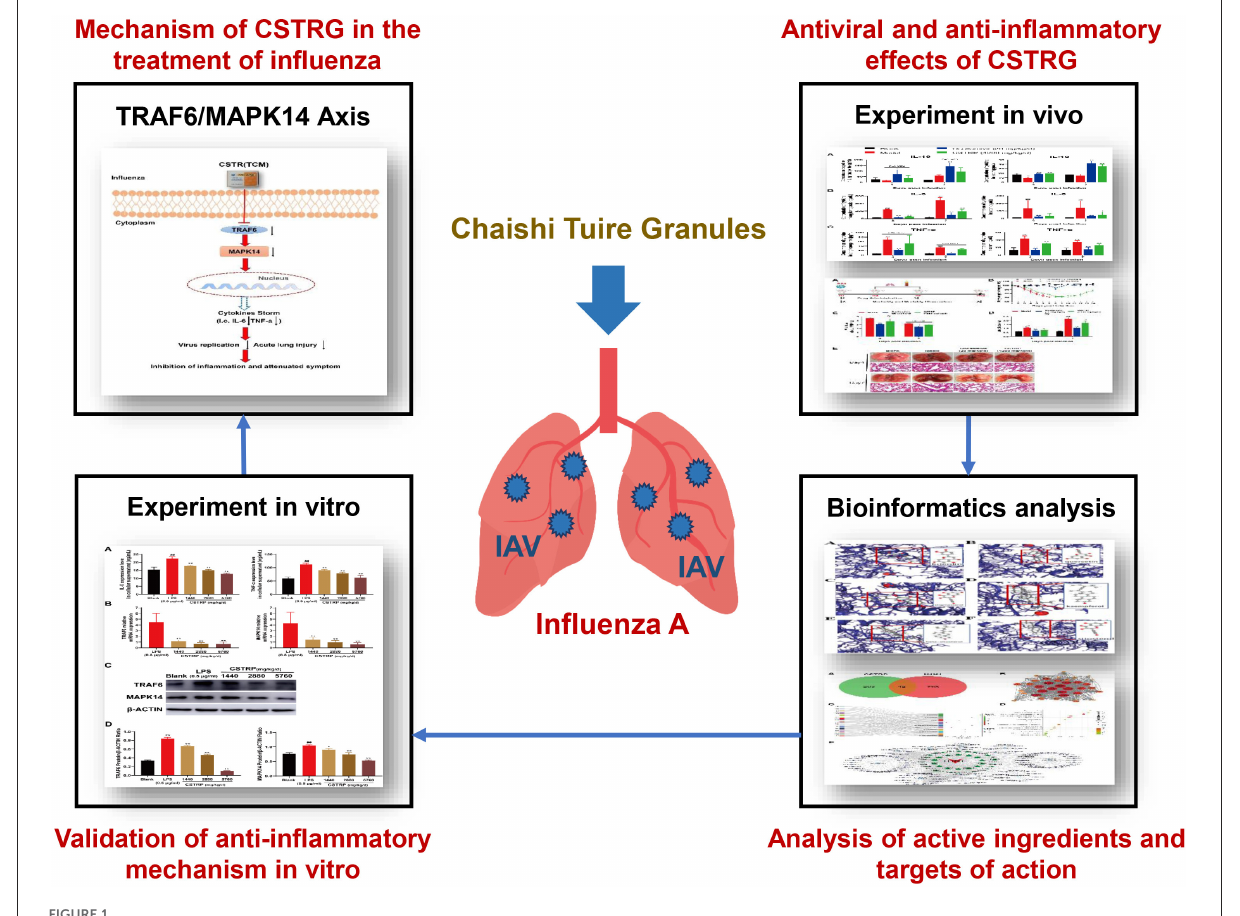
FIGURE1 Graphical summary of this